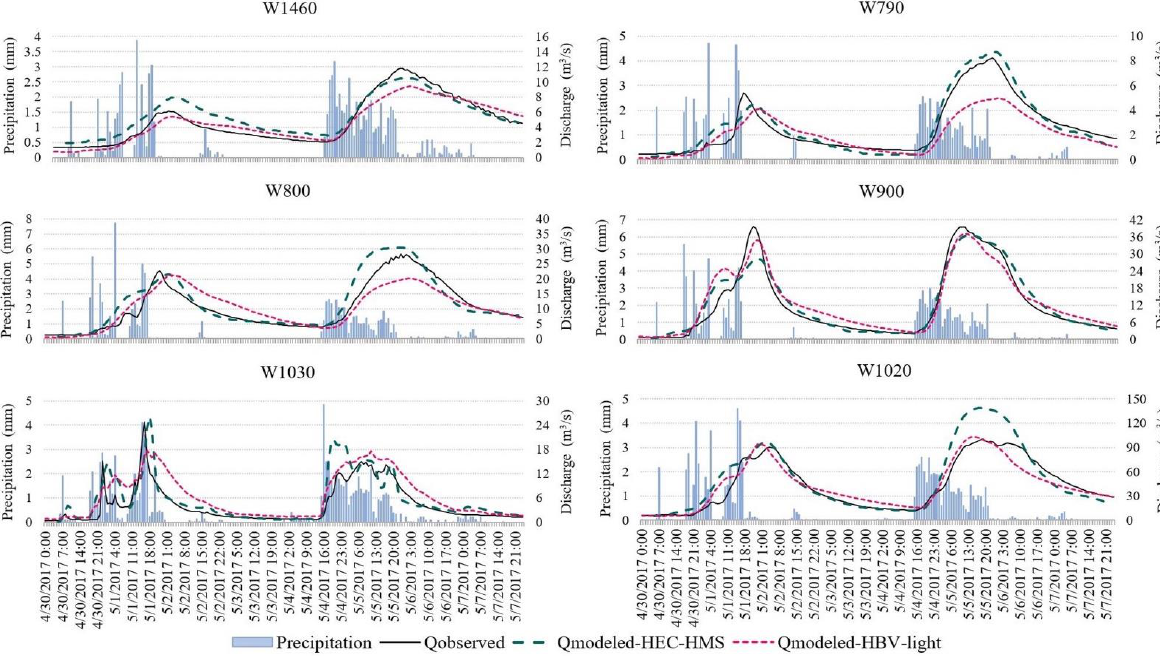
Figure 6. Precipitation, observed and modeled discharge of the 30 April – 7 May 2017 rain event at the six gauged stations.